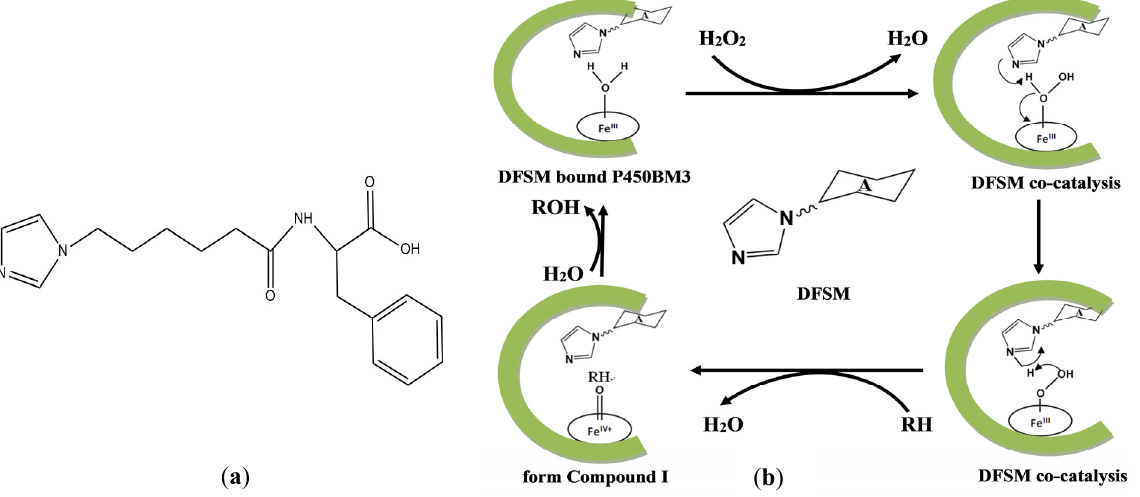
Figure 1. ( a ) The structure of the DFSM (Im-C6-Phe). ( b ) Proposed catalytic cycle of the artificial P450BM3 peroxygenase system, RH represents the substrate, and ROH represents the product.